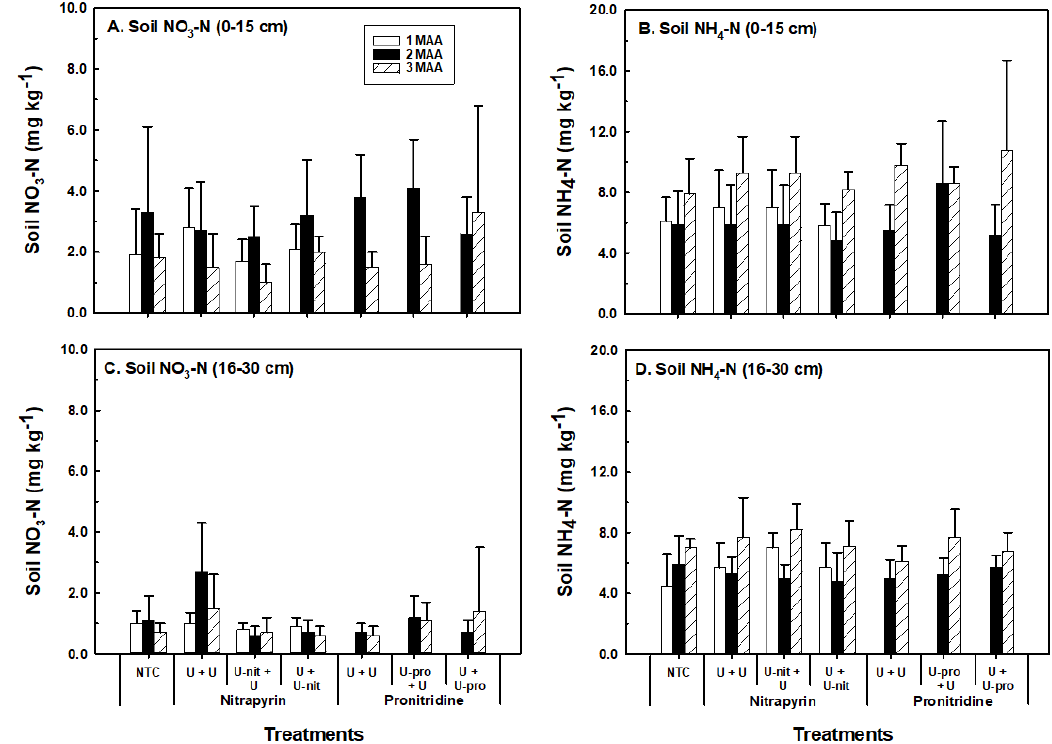
Figure 3. Soil test nitrate–nitrogen (NO 3 –N) concentration at 0–15 ( A ) cm and 16–30 ( C ) cm depths, and soil test ammonium–nitrogen (NH 4 –N) at 0–15 ( B ) cm and 16–30 ( D ) cm depths one, two, and three months after application (MAA) of a 40:60 split application of urea ammonium nitrate (U) totaling 79 kg N ha − 1 . Vertical error bars represent plus one standard deviation. Abbreviations: pro, pronitridine; nitr, nitrapyrin; NTC, non-treated control; U, urea ammonium nitrate. Application samples after one month were only taken for the non-treated control and nitrapyrin treatments.